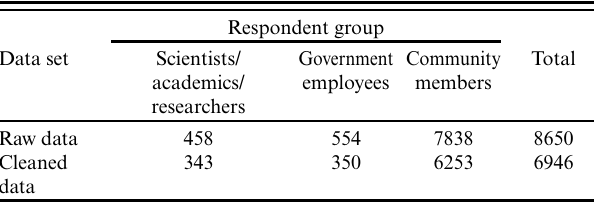
Table 1. Number of elicitations of word categories associated with climate change for three respondent